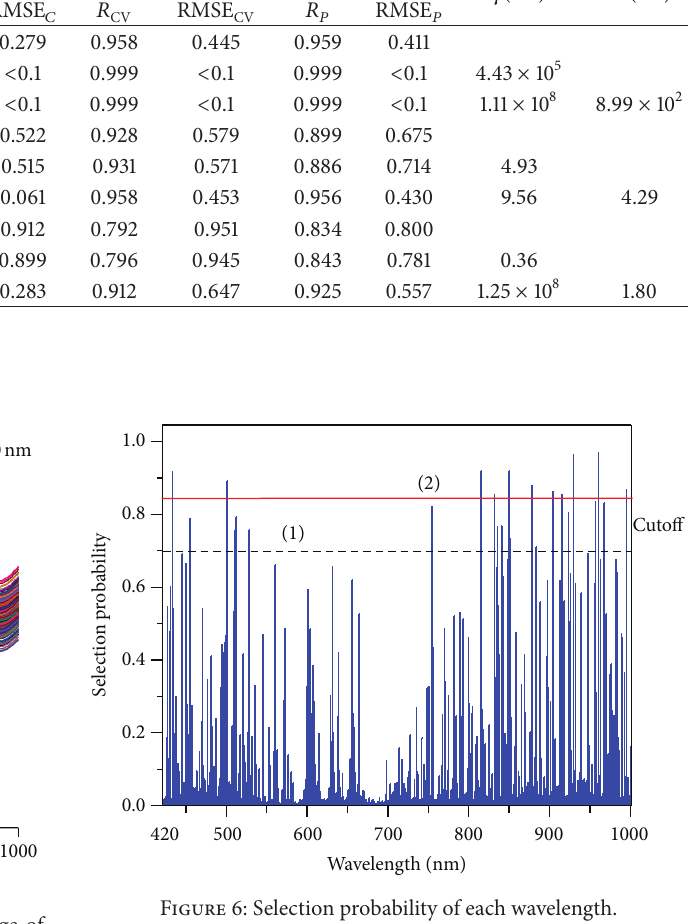
Table 2: Results of TSS predictive models of mulberries.